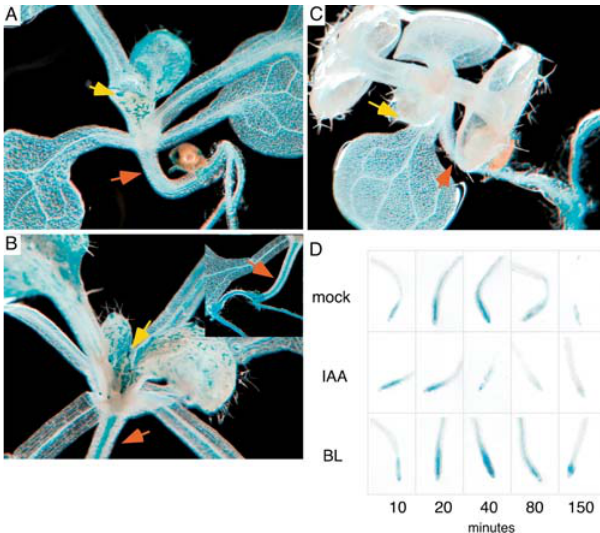
Figure 4. Endogenous BR Levels Affect Expression of an Auxin- Responsive Reporter but Do Not Induce Aux/IAA Protein Turnover (A) WT, (B) det2 , and (C) DW4FOX plants carrying the DR5::GUS transgene. (A) GUS staining is particularly strong in young leaves (yellow arrow). (B) det2 plants show no GUS staining in aerial tissues. (C) DWF4OX plants show increased intensity of staining, particularly at the tips of emerging leaves (yellow arrow) and in the hypocotyl (orange arrows). Inset shows hypocotyl-root junction. (D) Aux/IAA stability does not appear to be affected by treatment with BRs. Plants carrying a heat shock–inducible fusion of the N- terminal portion of AXR3 and GUS reporter were subjected to 2 h at 37 8 C and then treated with mock or hormone treatments for the time periods